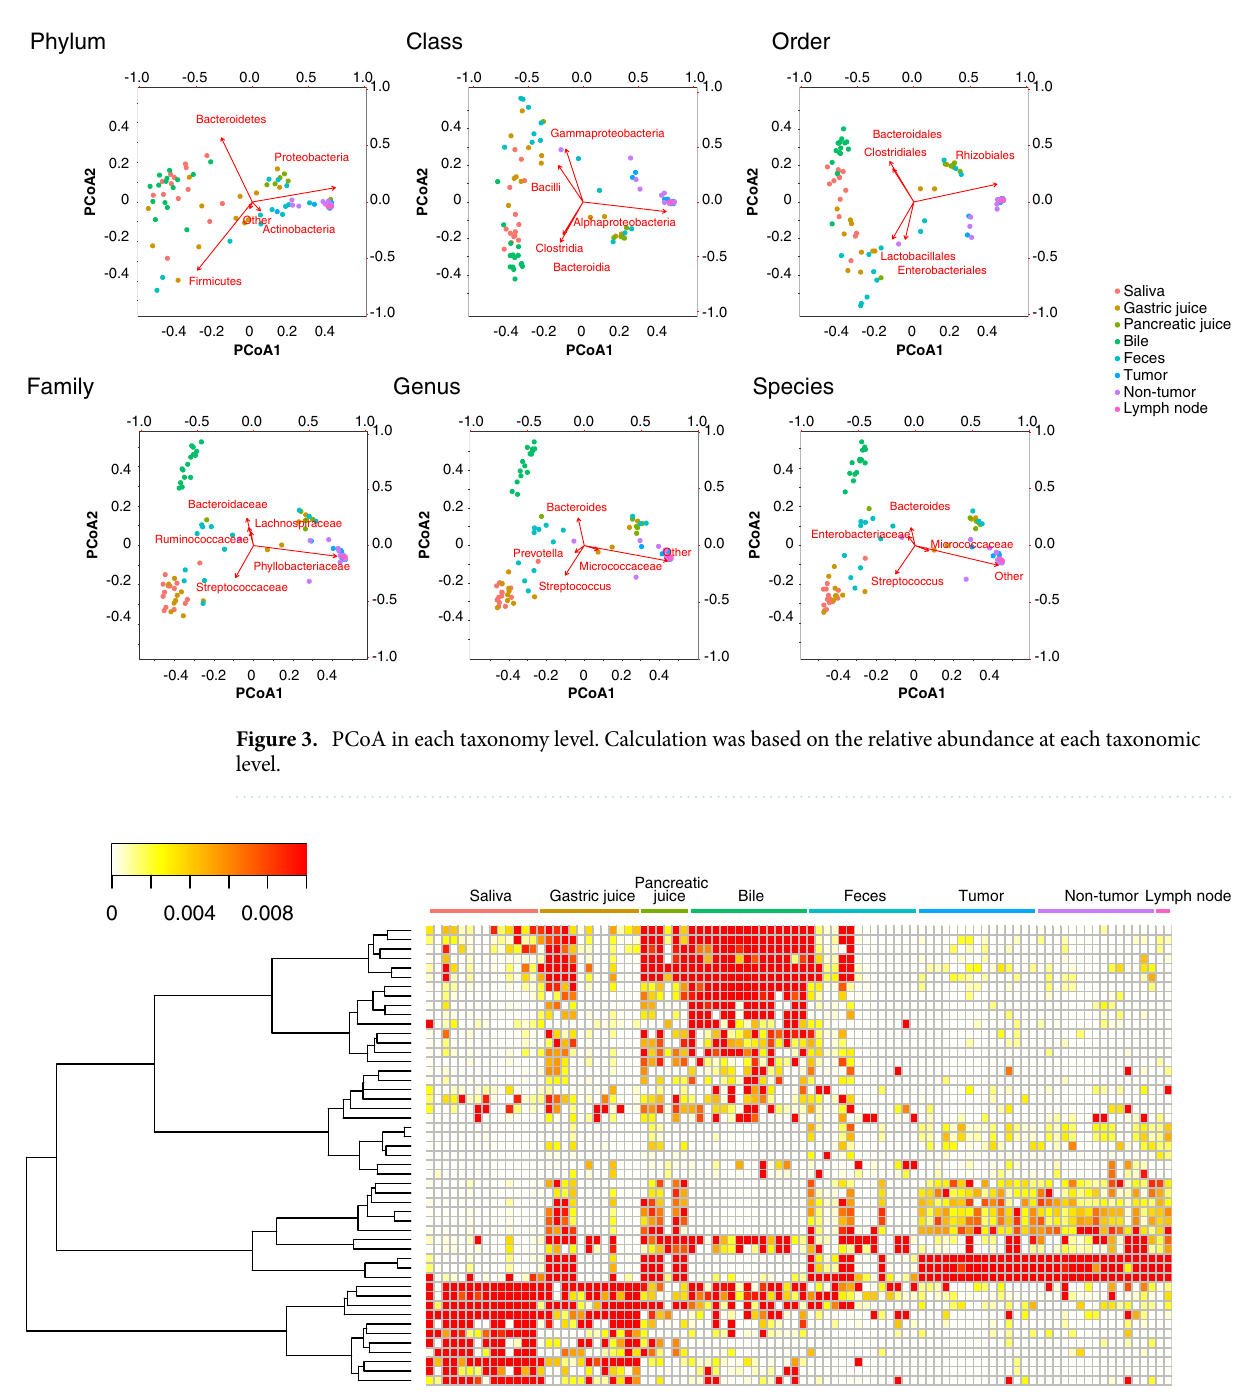
Figure 4. Clustering using Genus-level relative abundance. Clearly clustered areas are shown from the results of clustering using only genera with relative abundance of more than 1% (Supplementary Fig. 2). The relative abundance values were clustered using Euclidean distance and Ward’s